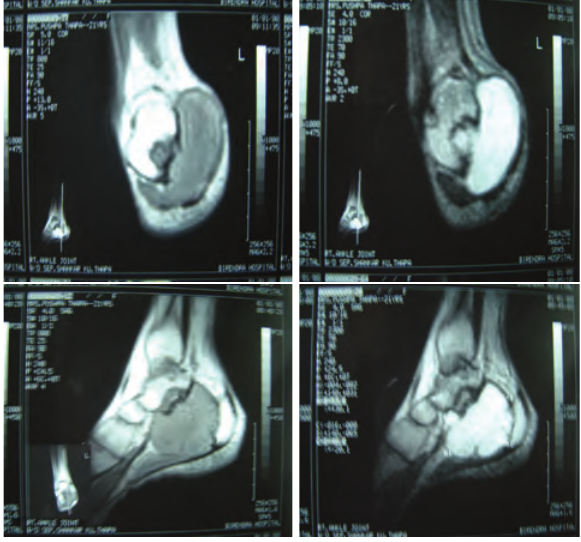
Figure 1. Clinical picture.